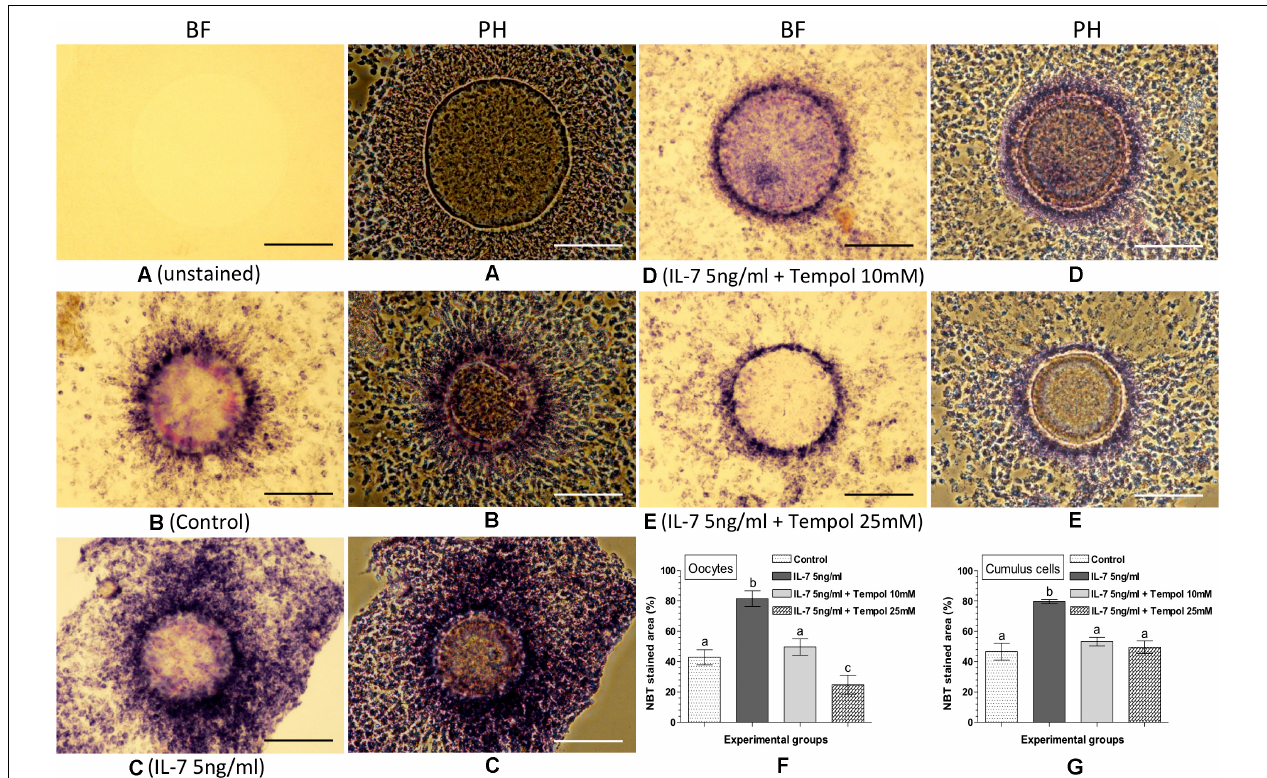
FIGURE 4 | Nitroblue tetrazolium (NBT) staining for assessing the combined effect of Interleukin-7 (IL-7) and superoxide ion scavenger (Tempol) on intracellular ROS in oocytes and cumulus cells. Ovine cumulus-oocyte complexes (COC) were matured in vitro without (control) or with the supplementation of IL-7 (5 ng/ml) or combination of IL-7 (5 ng/ml) and Tempol (10 or 25 mM) and stained with NBT. The dark purple/blue spots of formazan precipitates represent ROS. The level of intracellular ROS (% NBT stained area, mean ± SE) was determined in oocytes and cumulus cells from five individual COC in each experimental group. (A) Unstained COC, IL-7 supplemented group; (B) NBT-stained COC, control group; (C) NBT-stained COC, IL-7 supplemented group; (D,E) NBT-stained COC, combined supplementation (IL-7 + Tempol) groups; (F,G) level of intracellular ROS in oocytes and cumulus cells in different experimental groups. Values without a common superscript (a, b, c) above error bar differ significantly ( P < 0.05). BF, bright-field image; PH, phase-contrast image. Scale bar = 100 µ